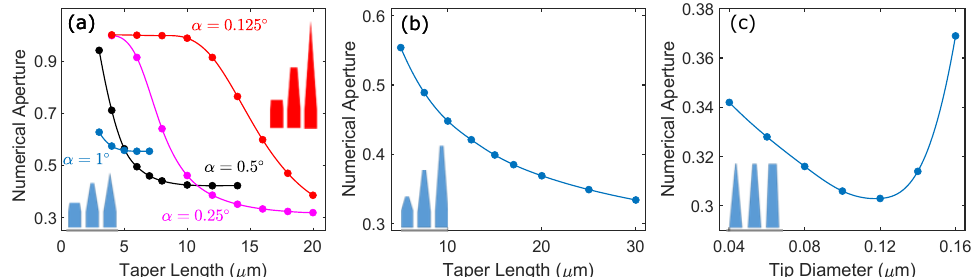
Figure 8. ( a , b ) Calculated numerical aperture of the nanowire source S NA as a function of taper length L T for different taper angles α . In ( a ), the tip diameter D t varies for each value of α whilst in ( b ), D t is fixed and α varies. ( c ) S NA as a function of D t for a fixed taper length of L T = 20 µ